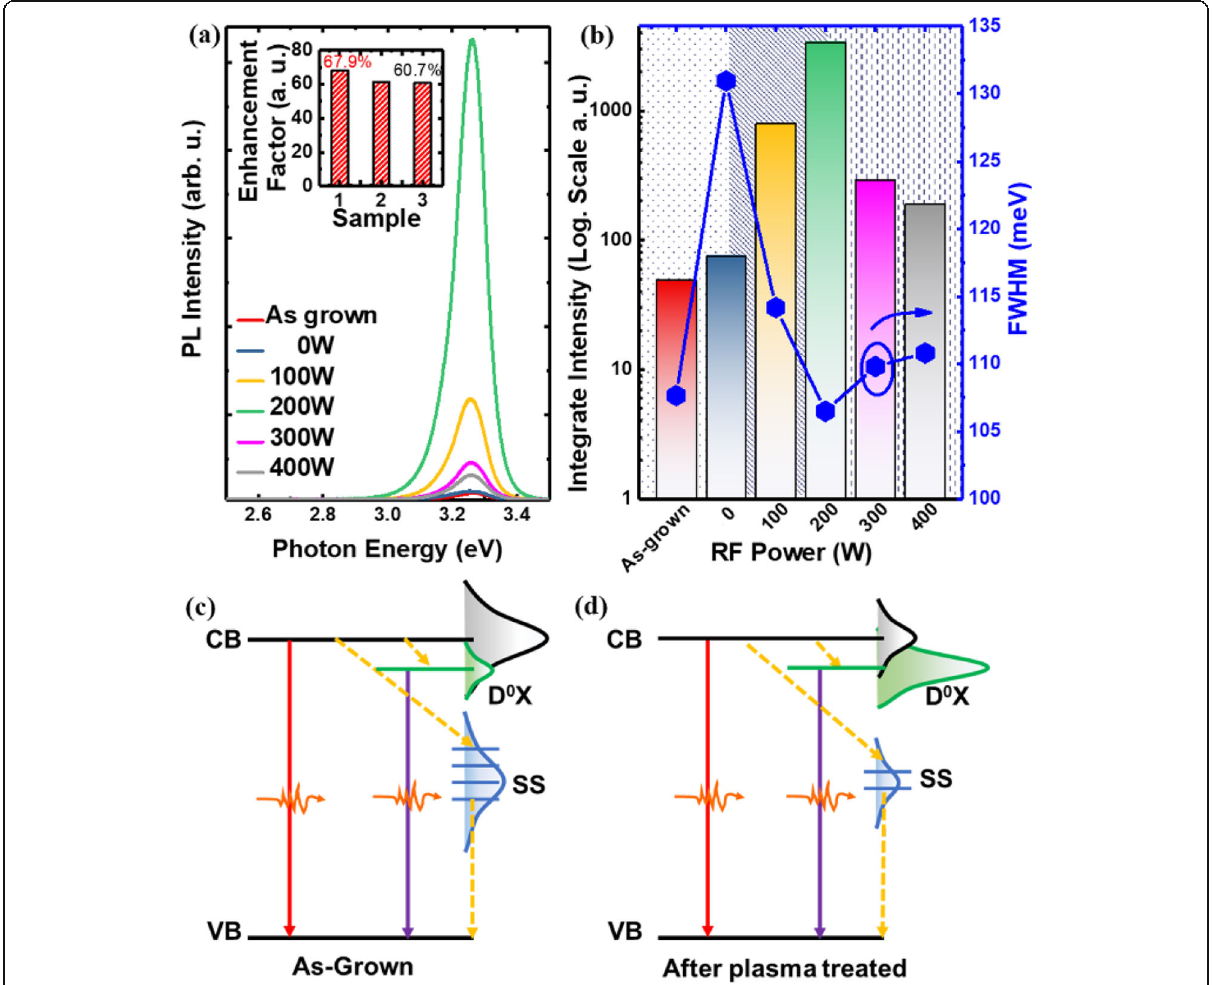
Fig. 2 a Room temperature PL spectra of the ZnO NWs treated by Ar plasma with different energies (inset shows the repeatability of this treatment). b Integrate intensity and FWHM with different energy plasma treated. c , d Schematic band structure of As-grown sample and after plasma-treated